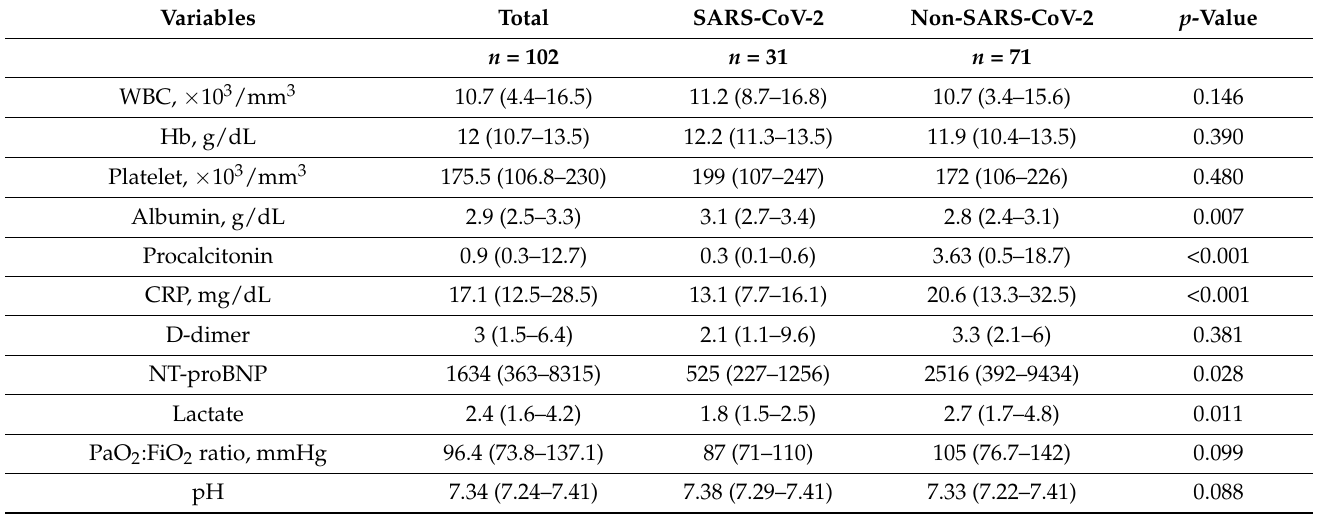
Table 2. Comparisons of laboratory, ventilator values, and microbiologic data at mechanical ventila- tion between SARS-CoV-2 and non-SARS-CoV-2 respiratory